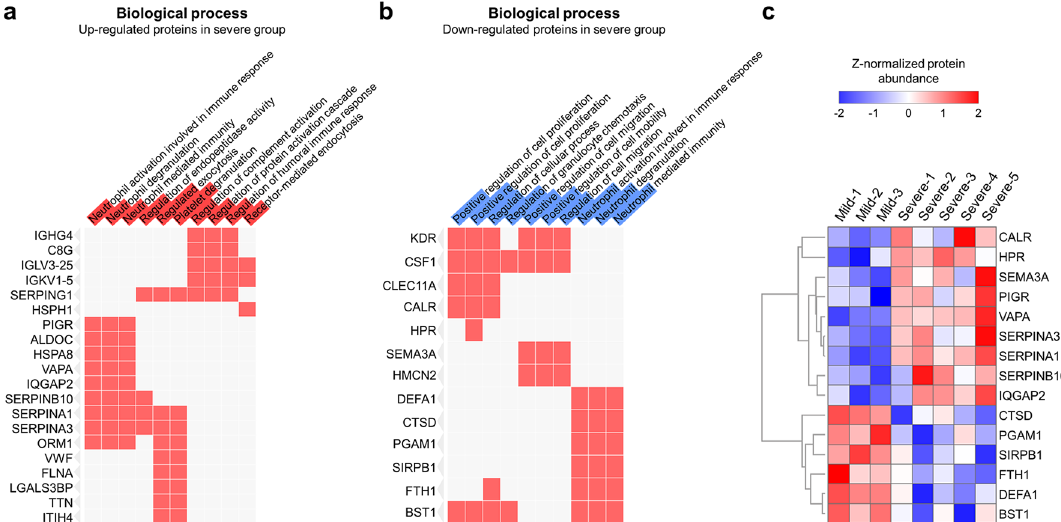
Figure 4. Functional analysis of differentially expressed proteins. ( a , b ) Biological function enrichment analysis was performed using the upregulated or downregulated DEPs. If the proteins on the left side were associated with the corresponding function, then they were filled with red. The level of significance of each biological function is displayed as the length of red ( a ) and blue ( b ) bars overlapped in the function term cell. ( c ) The expression levels of the 15 proteins associated with neutrophils were